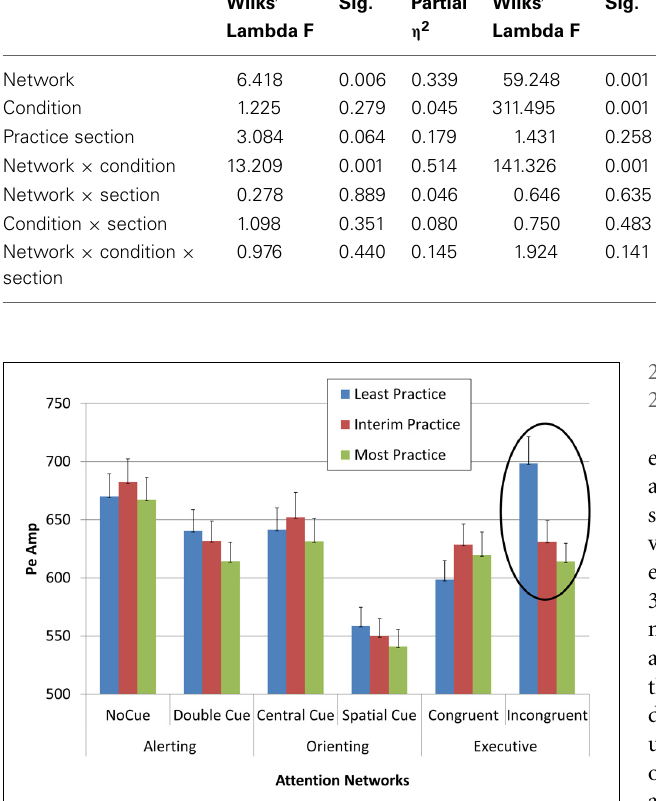
FIGURE 6 | Pe amplitude as a function of network, condition, and practice level.